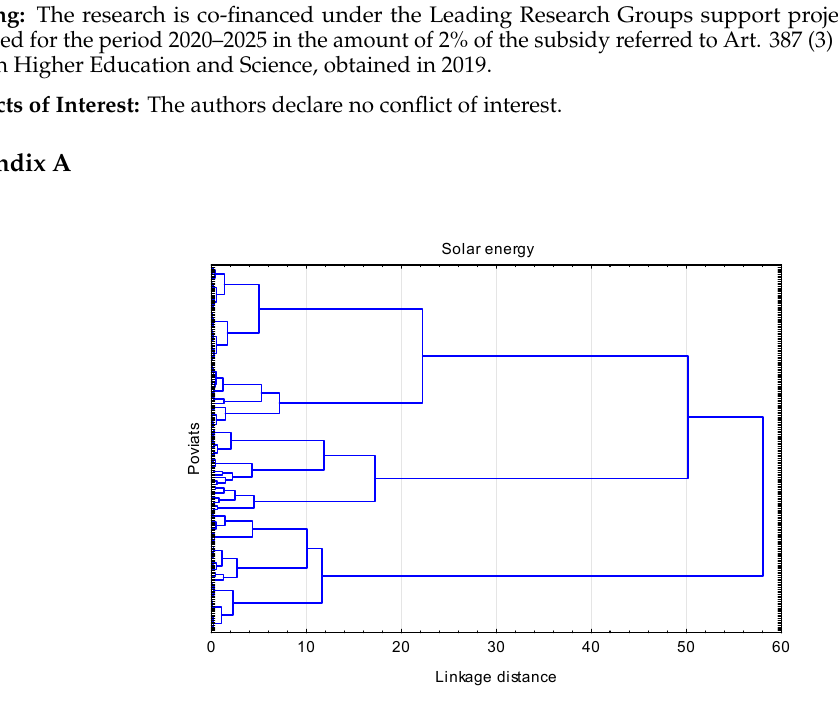
Figure A1. Dendrogram for poviats agglomeration, Ward linkage method with Euclidean distance–solar energy.